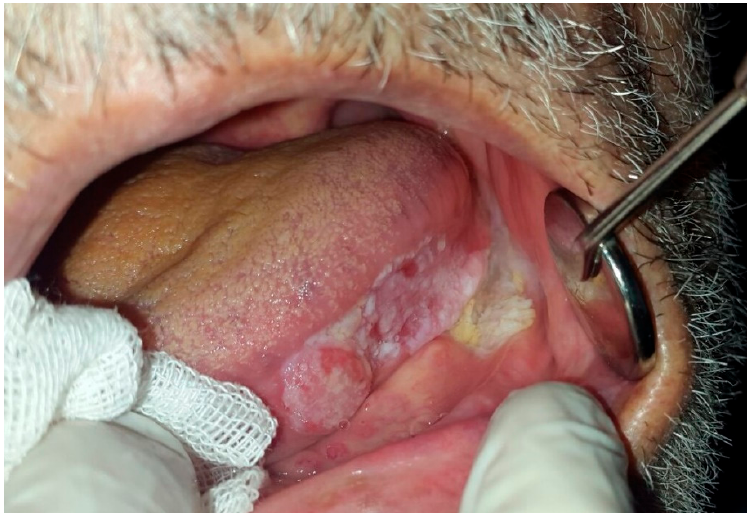
Figure 11. Squamous Cell Carcinoma with verrucous, plaque like and exophytic clinical manifestations at the lateral border of the tongue, extending to the floor of the mouth.